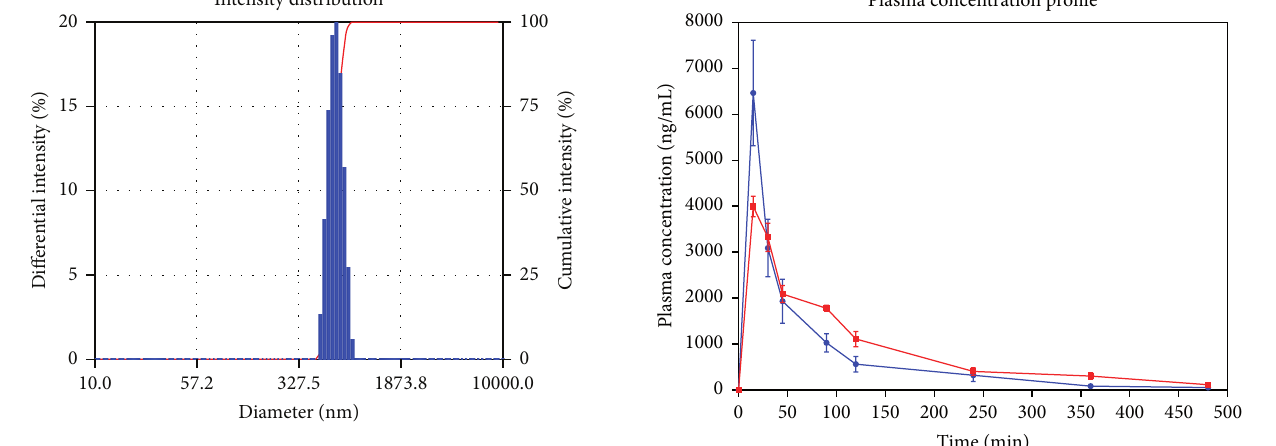
Figure 1: Particle size distribution graph of the optimized AZT-SLN formulation.